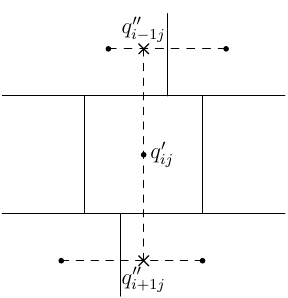
Figure 6. Zonal interpolation to compute the meridional gradient of q (cid:48) ij